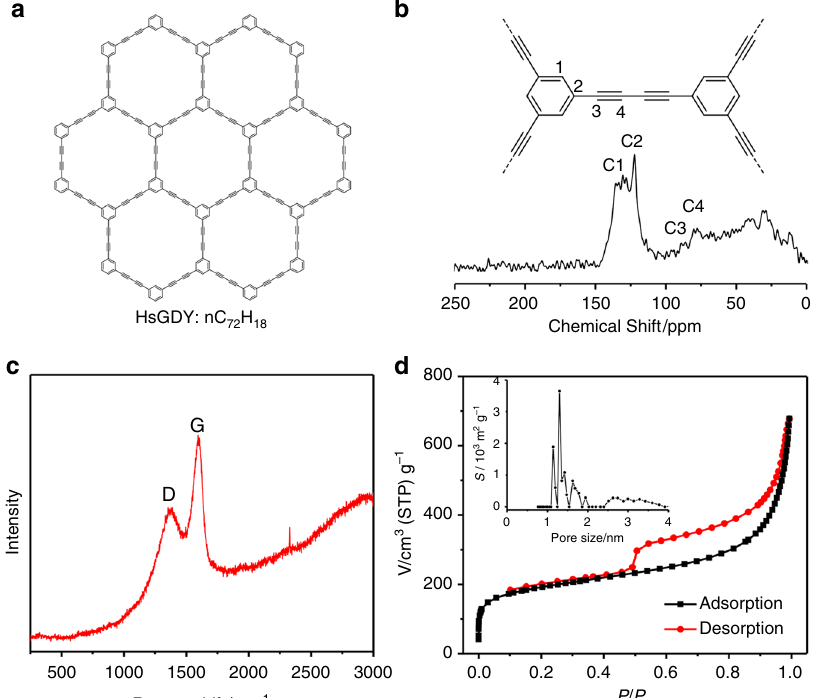
Fig. 3 Structural characterizations of hydrogen-substituted graphdiyne. a Schematic illustration, b solid 13 C nuclear magnetic resonance (NMR) spectrum, c Raman spectrum, and d N 2 adsorption/desorption isotherms of the discerte conformal coated hydrogen-substituted graphdiyne (HsGDY). The inset of d is the corresponding pore size distribution